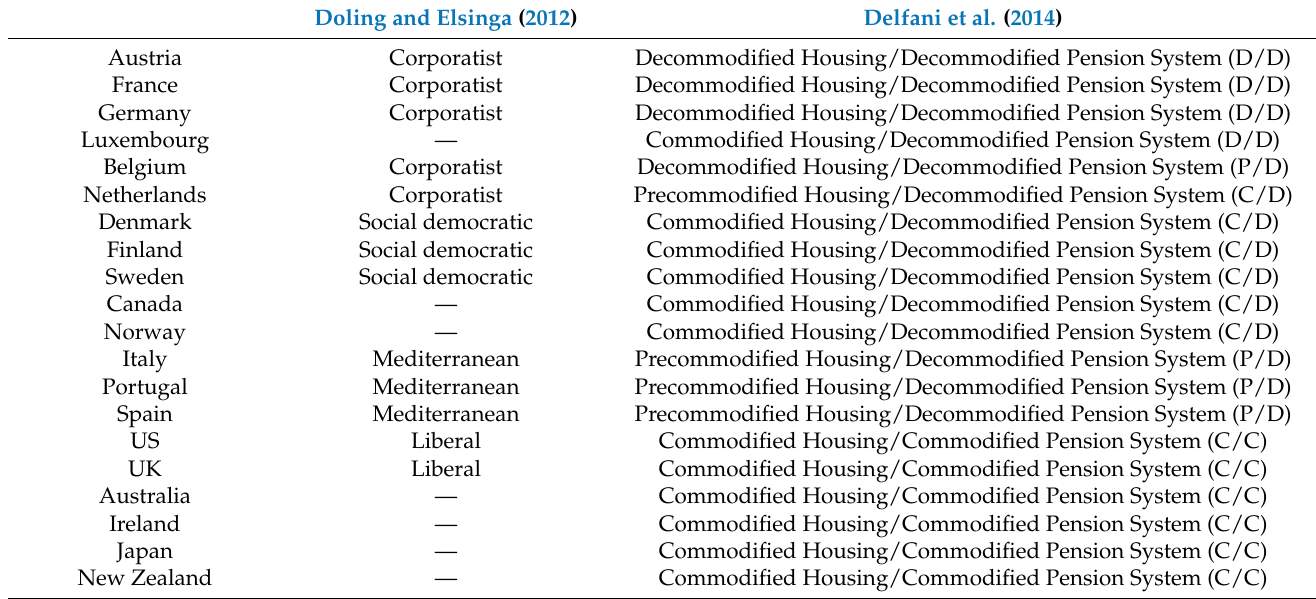
Table 1. National housing and pension system typologies. Doling and Elsinga